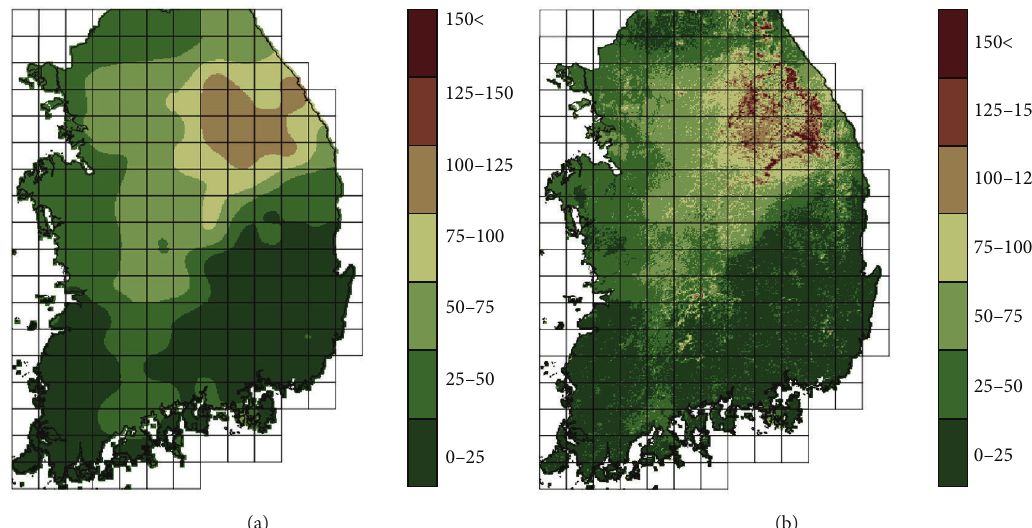
Figure 4: Downscaling results by area-to-point residual kriging: (a) downscaling without DEM and NDVI and (b) downscaling with DEM and NDVI.